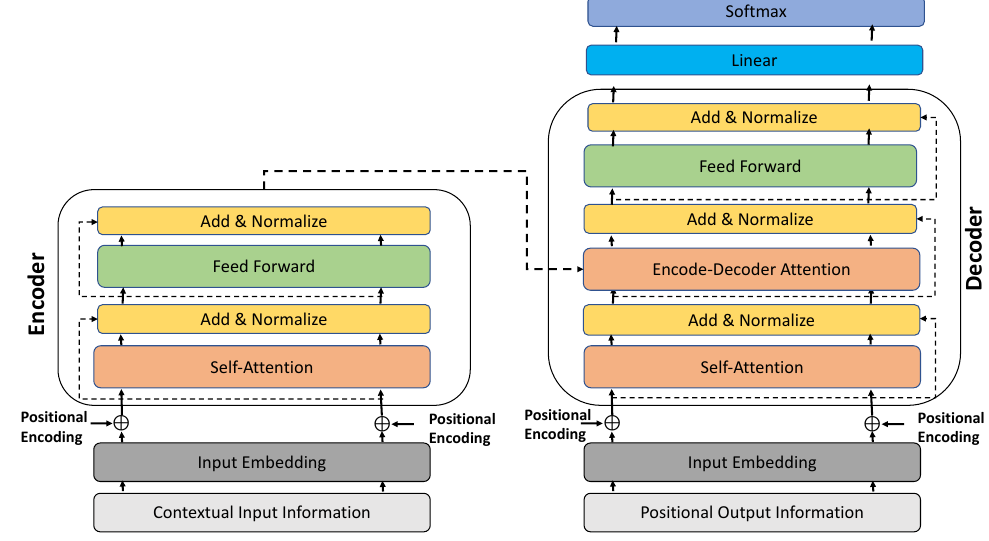
Figure 2. The building blocks of our proposed context-augmented transformer